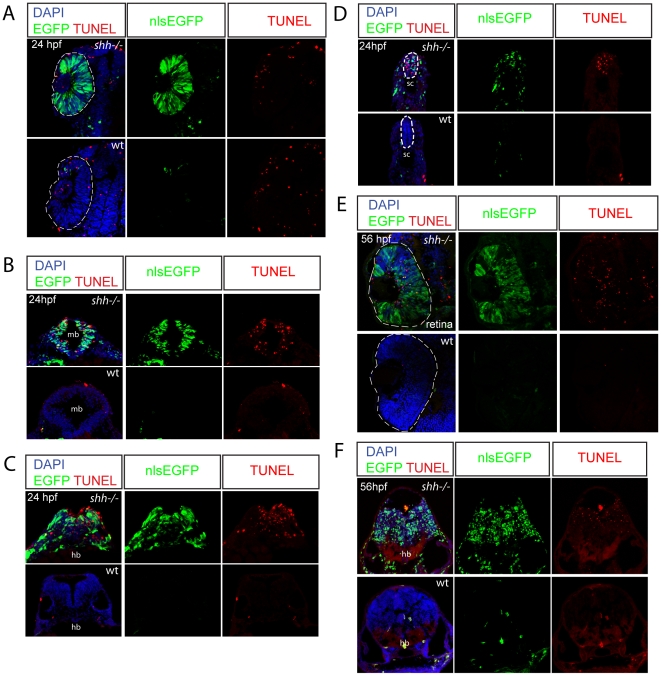
Expression of p53 reporter and apoptosis are strongly elevated in the shh
−/− mutant embryos.Wild-type and shh
−/− embryos at 24hpf (A–D) and 56 hpf (E, F) carrying p53 reporter transgene (PG13p21::nlsEGFP) were transversally sectioned, nuclei were stained with DAPI and apoptotic cells – with TUNEL, nlsEGFP signal is endogeneous (A–F). The developing nervous system of shh
−/− mutant embryos showed high level of p53 reporter expression and apoptosis compared to wild-type embryos at both 24 (B–D) and 56 hpf (F). (A) At 24 hpf, p53 reporter was strongly induced in the shh
−/− mutant compared to the wild-type retina, but there was no elevated apoptosis in the shh
−/− mutant retina. (B) Expression of p53 reporter and TUNEL labeling in midbrain of shh
−/− mutant and wild-type embryos at 24 hpf. (C) Expression of p53 reporter and TUNEL labeling in hindbrain of shh
−/− mutant and wild-type embryos at 24 hpf. (D) Expression of p53 reporter and TUNEL labelling in spinal cord of shh
−/− and wild-type at 24 hpf. (E) At 56 hpf, both p53 reporter expression and apoptosis were much higher in the shh
−/− retina than in the wild-type retina. (F) Expression of p53 reporter and TUNEL labelling in hindbrain regions of shh
−/− and wild-type embryos at 56 hpf.